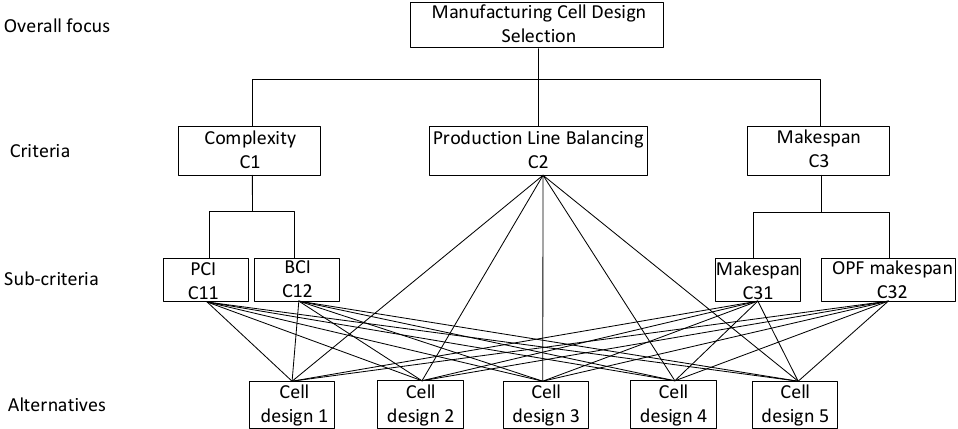
Figure 6. Hierarchical structure of the AHP method for selection of an optimal manufacturing cell.